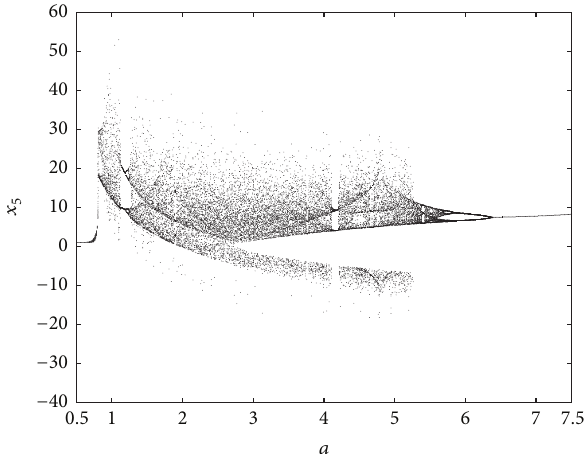
Figure 2: The bifurcation diagram of the system (14) with parameter 𝑎 ∈ [0.5, 7.5] .